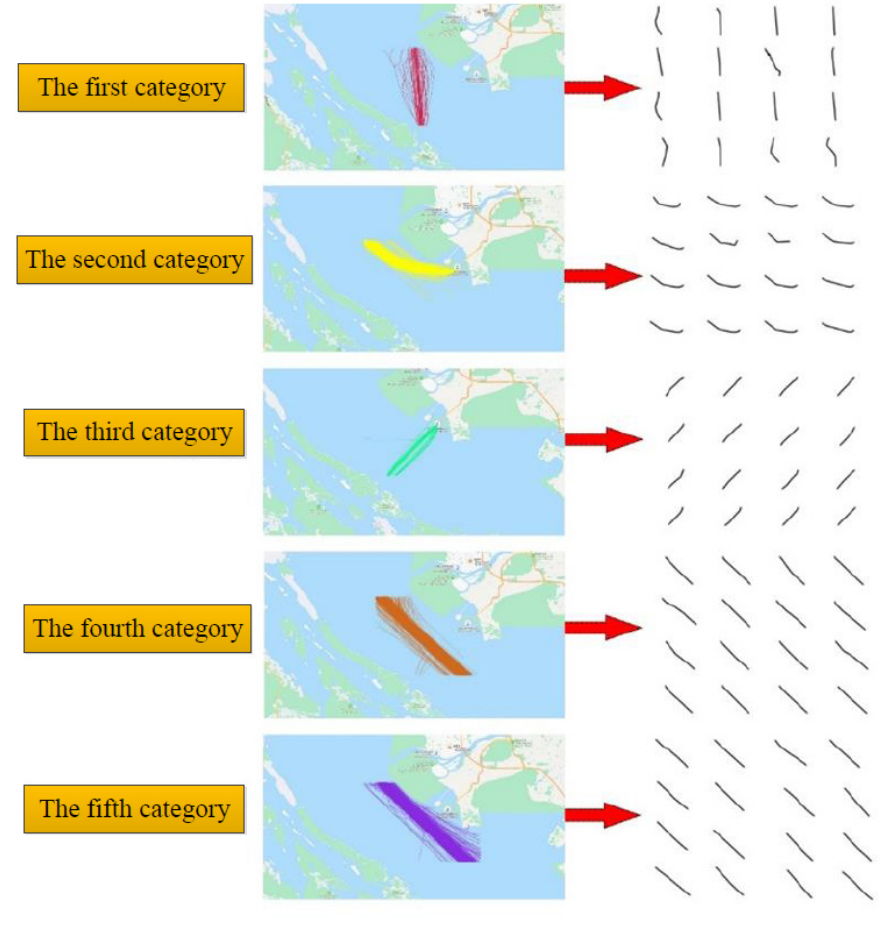
Figure 8. Trajectory image data display diagram.